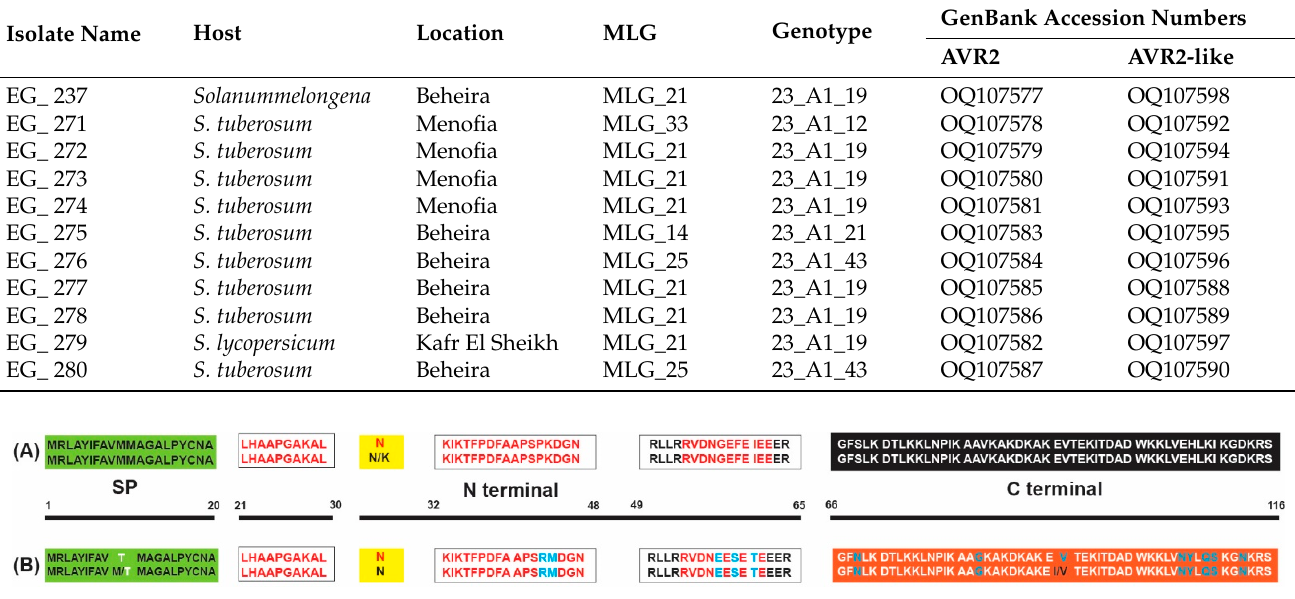
Figure 10. Amino acids alignment of the two effector genes AVR2 ( A ) and AVR2-like ( B ). The numbers above the black line show the start and end positions for each domain.